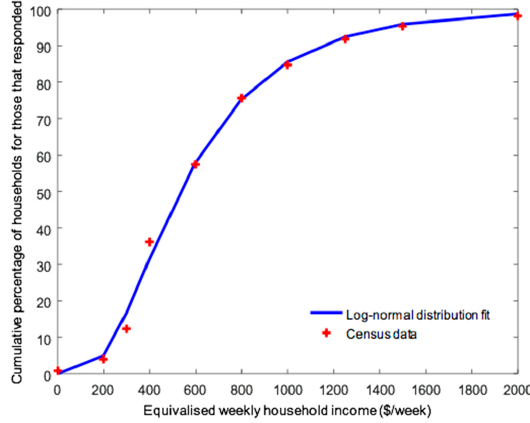
Figure A1. Comparison of log-normal cumulative regression fit of mean equivalised weekly income levels with base 2011 Census data for 1 randomly selected SA2 region (Cowra, NSW).